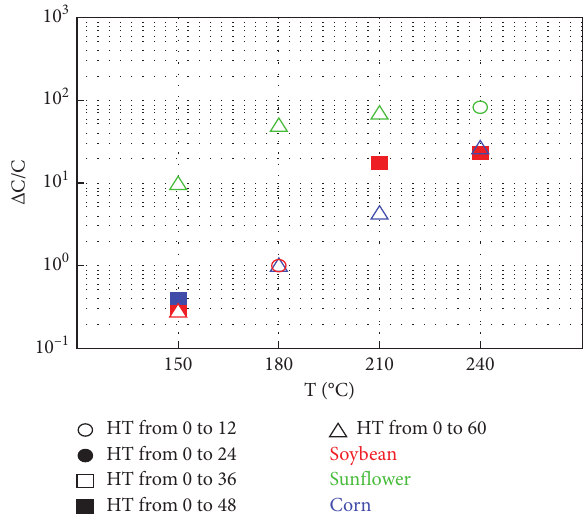
Figure 1: Effect of the temperature on the maximum change rate of fatty acids over all the three species (soybean, sunflower, and corn). The heating times (HT) are represented as supplementary ex- planatory